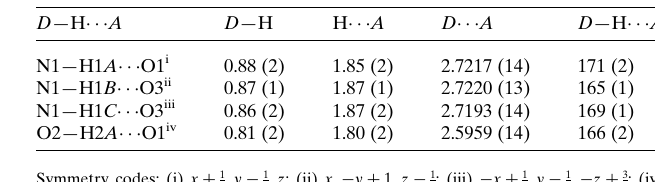
Table 1 Hydrogen-bond geometry (A˚ , (cid:5) ).